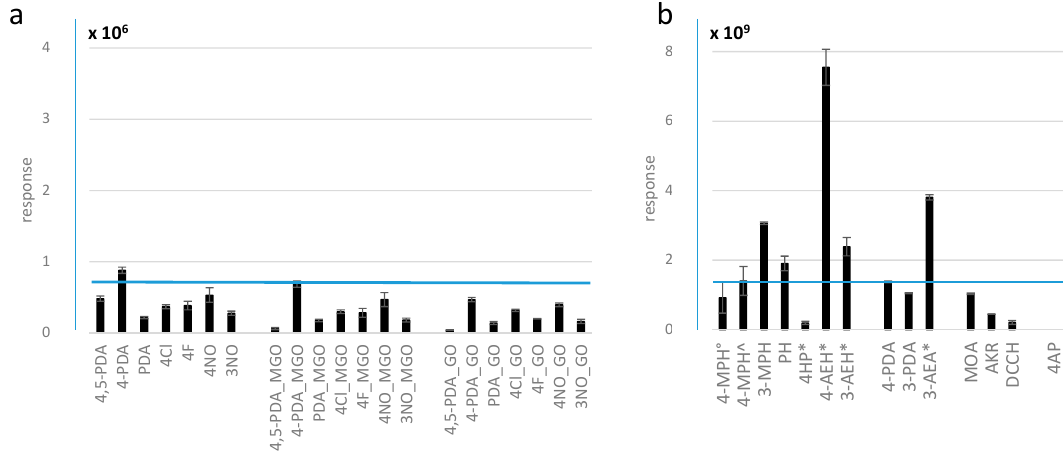
Figure 3. Relative abundances of the different reagents and their corresponding derivatives. Response is normalized to the peak of the two co-eluting products of MGO with 4-methoxyphenylenediamine within each experiment, the isomers 6- and 7-methoxy-2-methylquinoxaline (4-PDA_MGO in Figure 3a and 4-PDA in Figure 3b), illustrated by the blue horizontal line. ( a ) Relative response of the protonated molecular ions of phenylenediamine reagents (left) compared to the quinoxaline reaction products after incubation with MGO (middle) and GO (right). ( b ) Relative response of the most abundant reaction product of methylglyoxal with the corresponding reagent, including phenylhydrazines, methoxyphenylenediamines, and hydroxylamines. ( ◦ indole after two days incubation, ˆ diimine after four days incubation, * monoderivative). The structure of all reagents is presented in Figure 2. All abbreviations are listed in Supplementary Table S2.